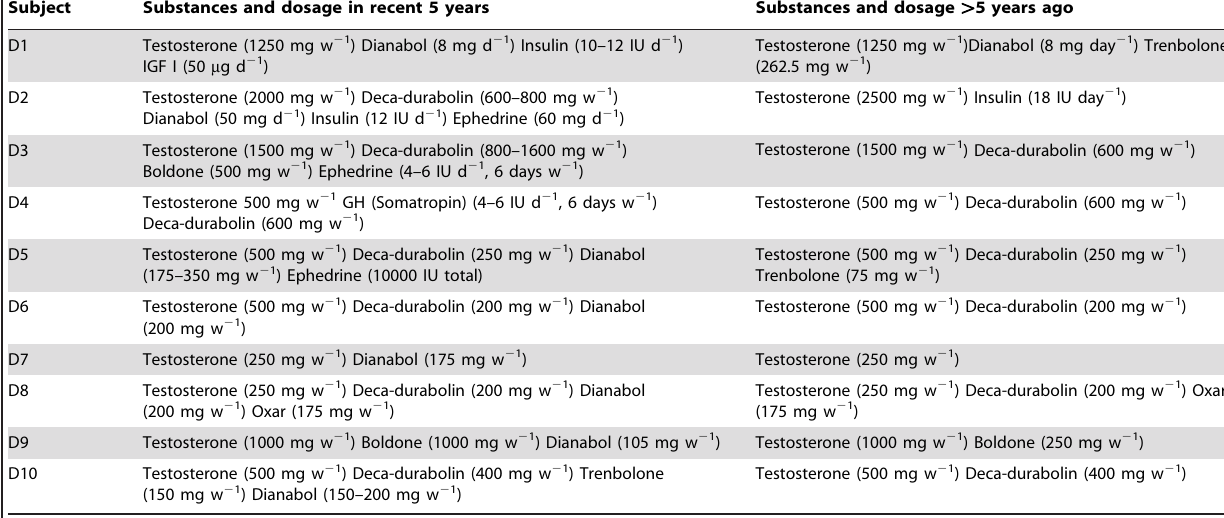
Table 1. Self-reported intake of banned substances in the Doped